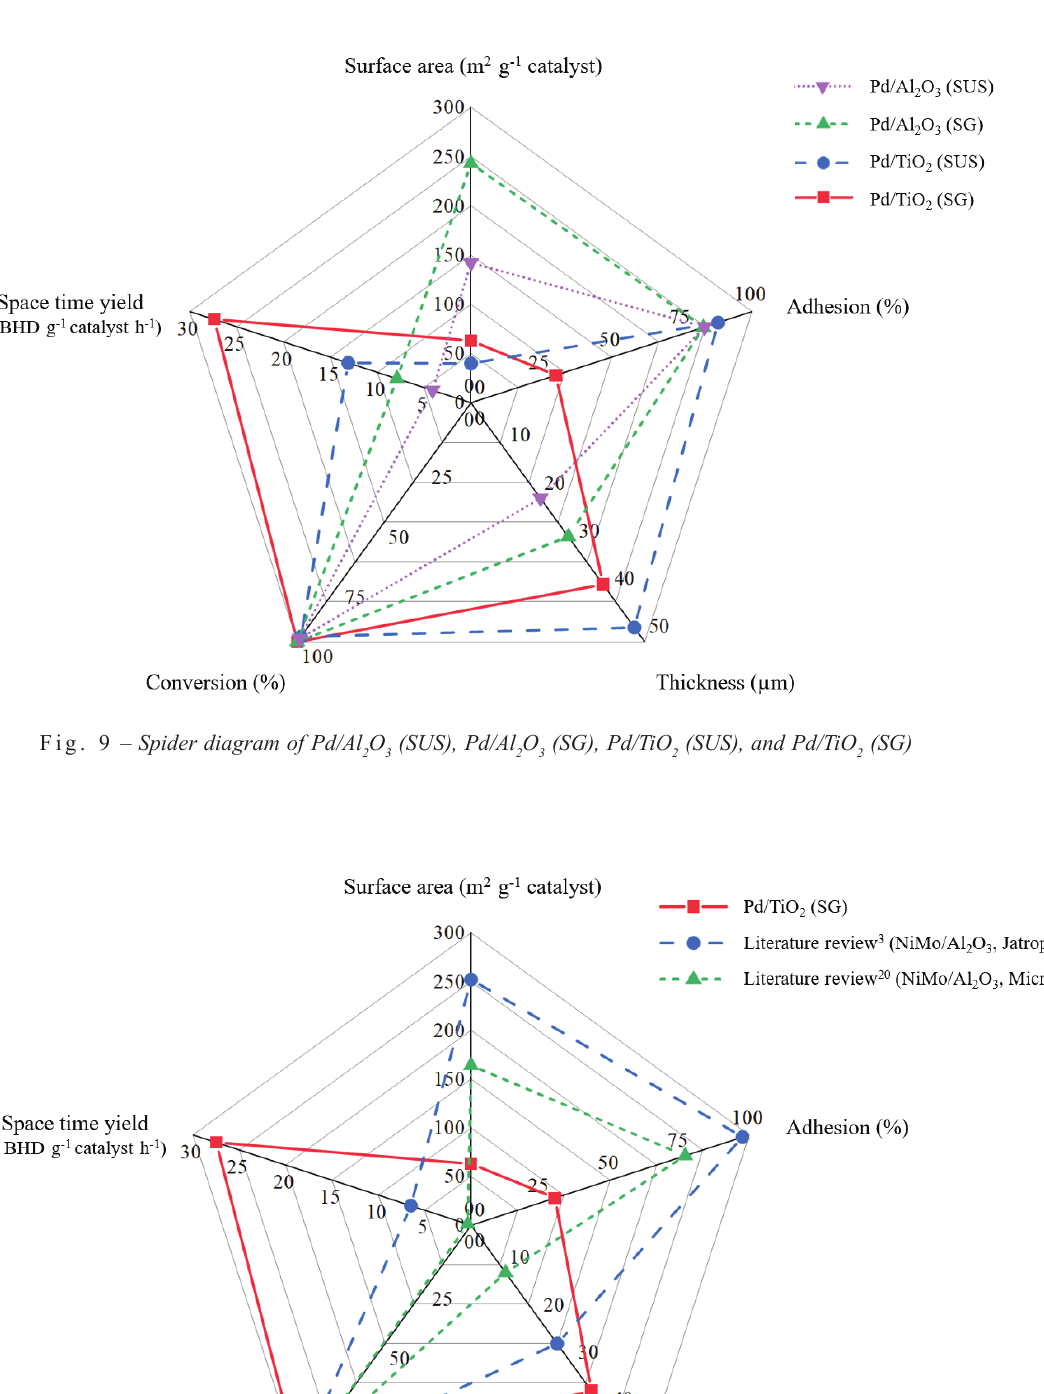
Fig. 10 – Comparison of Pd/TiO (SG) catalyst performance with catalysts 3,20 performing similar chemical reaction 2